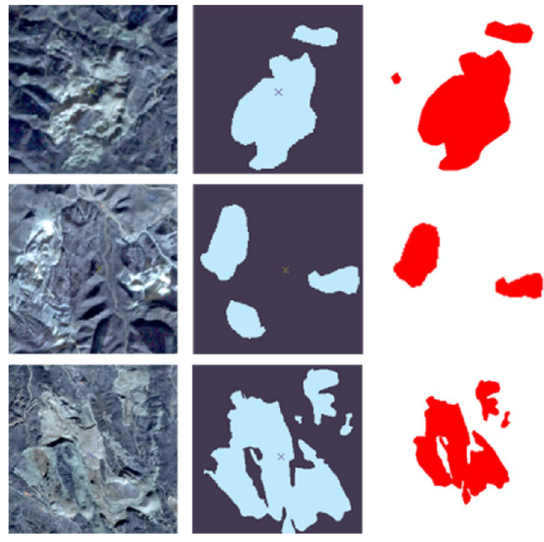
Fig. 9 The first column is the original image, the second column is the ground true data, and the third column is the proposed model extraction result